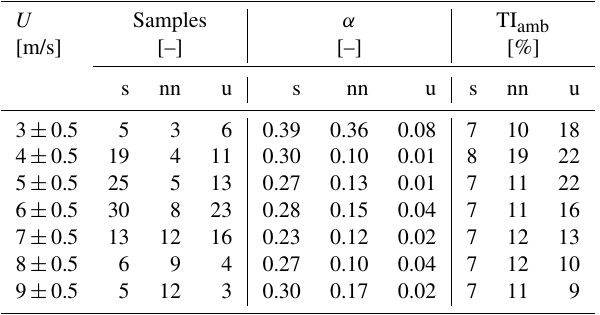
Table 1. Dataset from Strategy I . The data are classified according to wind speed bins of 1m/s and three atmospheric-stability classes: stable (s), near-neutral (nn), and unstable (u). The number of 10min samples is also indicated; α is the power-law shear exponent; TI amb is the turbulence intensity defined as the standard deviation of hori- zontal wind speed divided by the mean wind speed. The wind speed and turbulence parameters are obtained from sonic observations at 32m height. U Samples